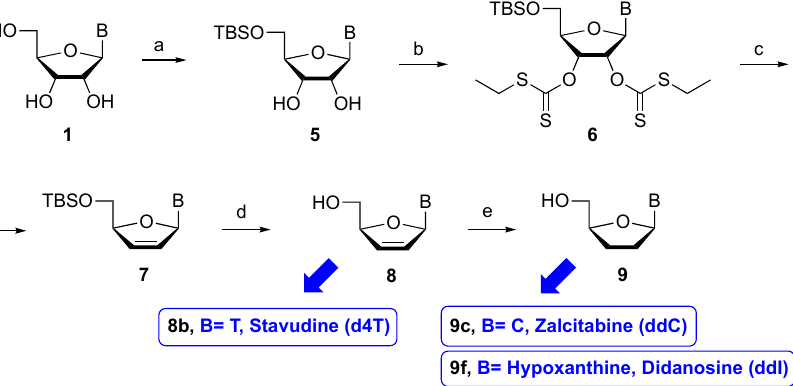
Scheme 3. Synthesis of 2 ′ ,3 ′ -didehydro-2 ′ ,3 ′ -dideoxynucleosides and 2 ′ ,3 ′ -dideoxynucleosides. Synthesis of d4T, ddC and ddI. Reagents and conditions : ( a ) TBSCl, imidazole, DMF, rt, 12 h; ( b ) (1) CS 2 ,